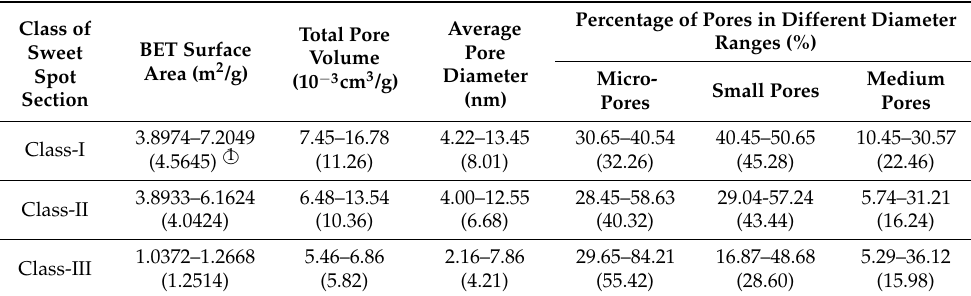
Table 4. Pore structure parameters of shale samples from different sweet spot sections of Da’an area, southern Songliao Basin obtained from N 2 GA